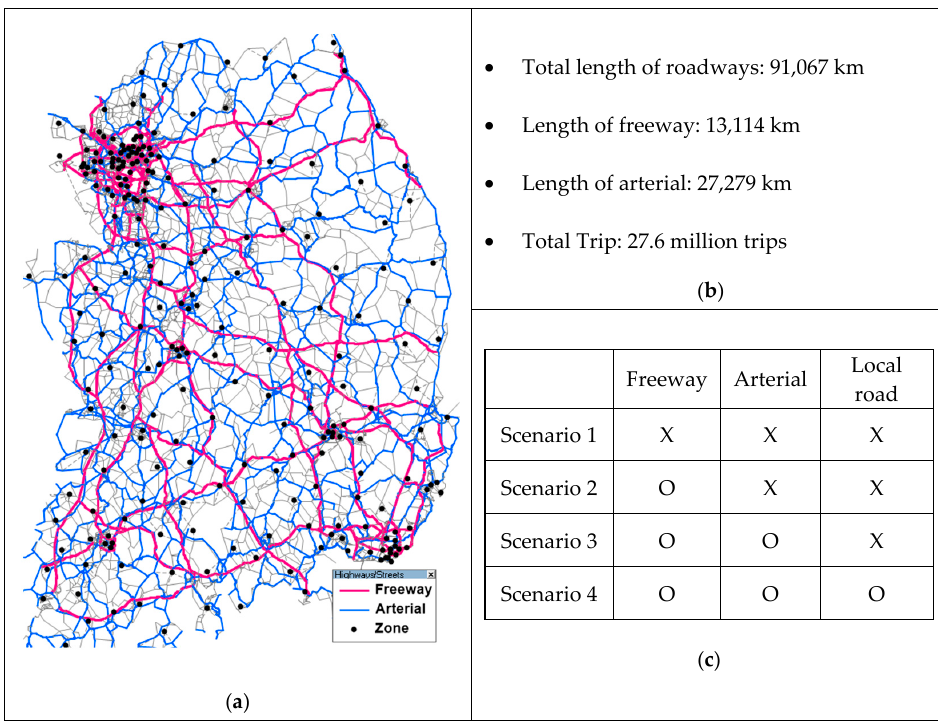
Figure 7. Korea network and analysis scenarios. ( a ) Test network; ( b ) network characteristics; ( c ) available roads for CAVs.